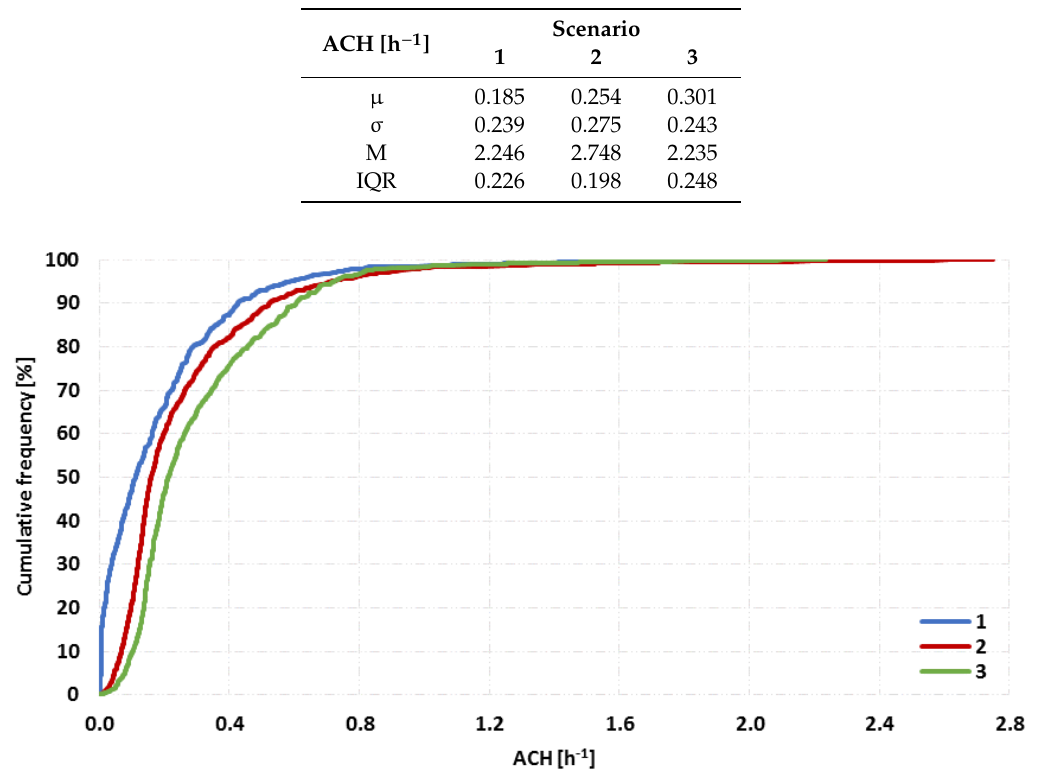
Figure 6. Cumulative frequencies of ACH for the modeled scenarios on air leakage paths configuration; scenarios—1 (blue), 2 (red), 3 (green).